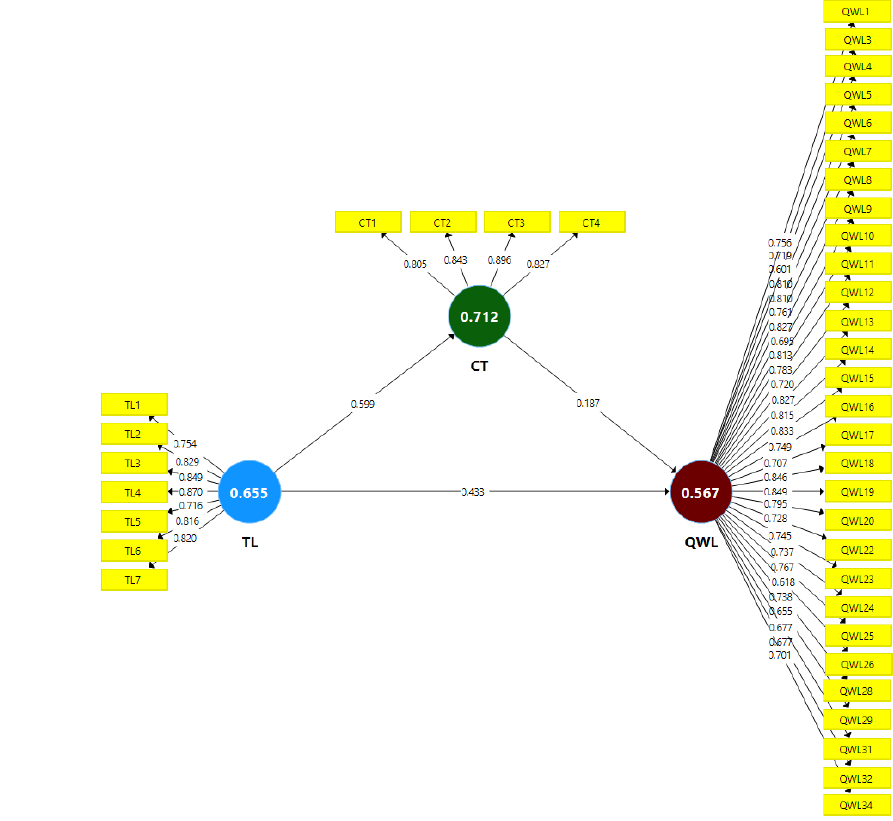
Figure 2. Measurement